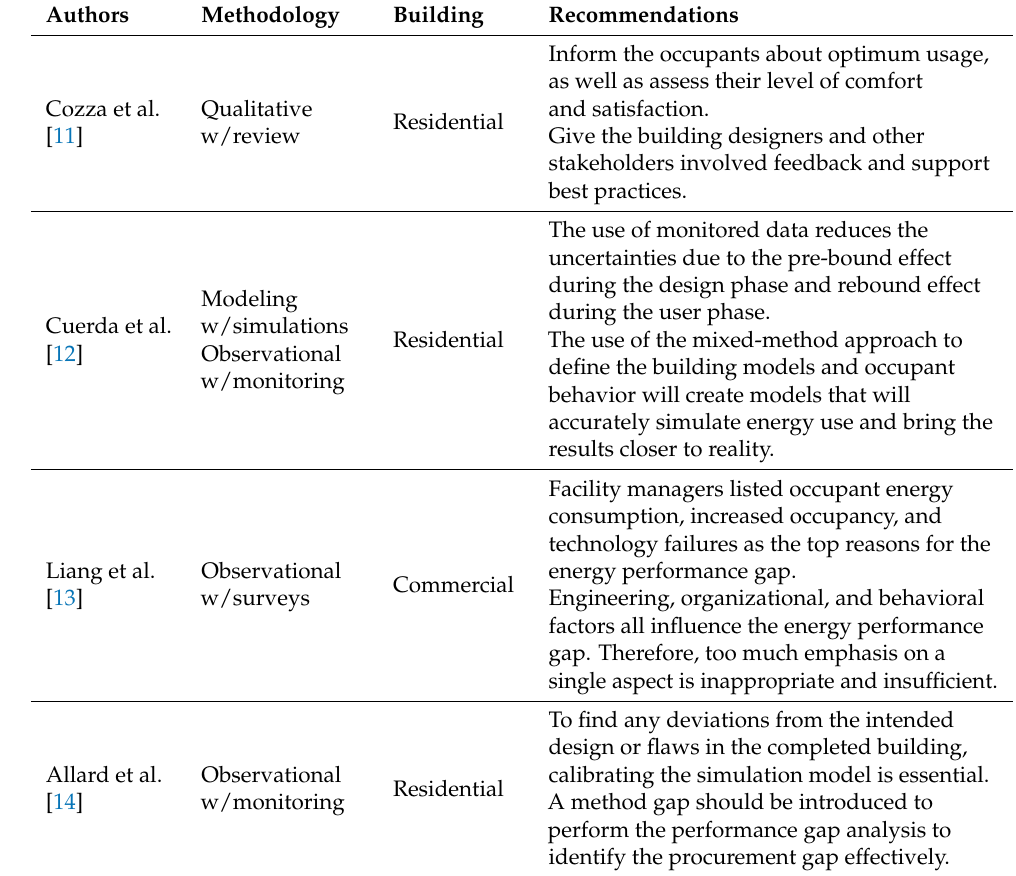
Table 1. Summary of existing studies that address the energy performance gap in